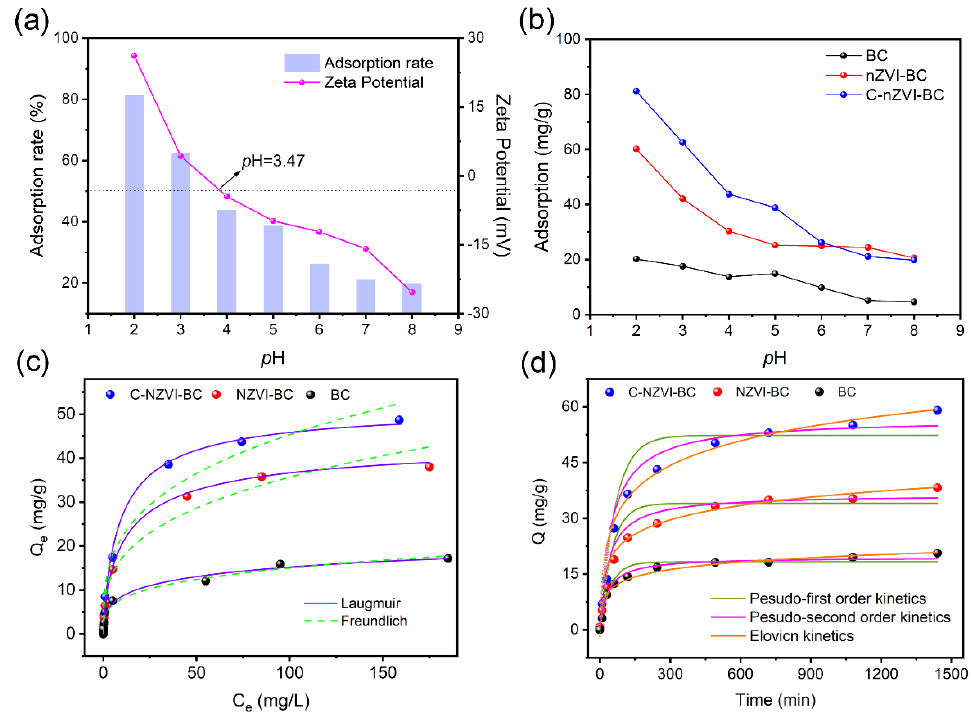
Figure 4. Sorption performance of hexavalent chromium (Cr(VI)) onto three adsorbents. Sorption rate and zeta potential of C – nZVI – BC in different pH solutions ( a ); effect of pH on the sorption of Cr(VI) onto adsorbents ( T = 30 °C, V = 100 mL, weight of adsorbents = 100 mg, and initial Cr(VI) concentration = 100 mg/L) ( b ); Cr(VI) sorption isotherms and fitting results ( c ); and Cr(VI) sorption kinetics and fitting results ( d ) (pH = 2, shaking for 24 h).